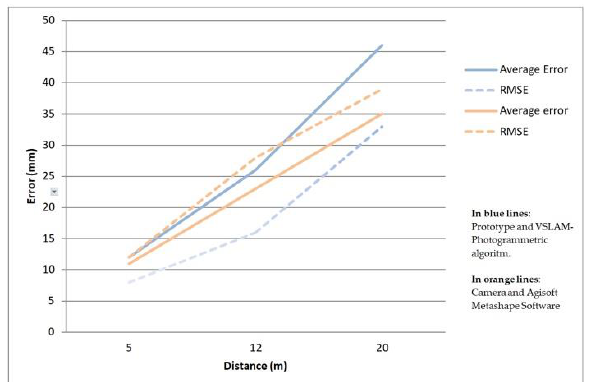
Figure 8. Visual comparison of 3D models generated with the laser scanner (left) and with the proposed videogrammetric system (right).